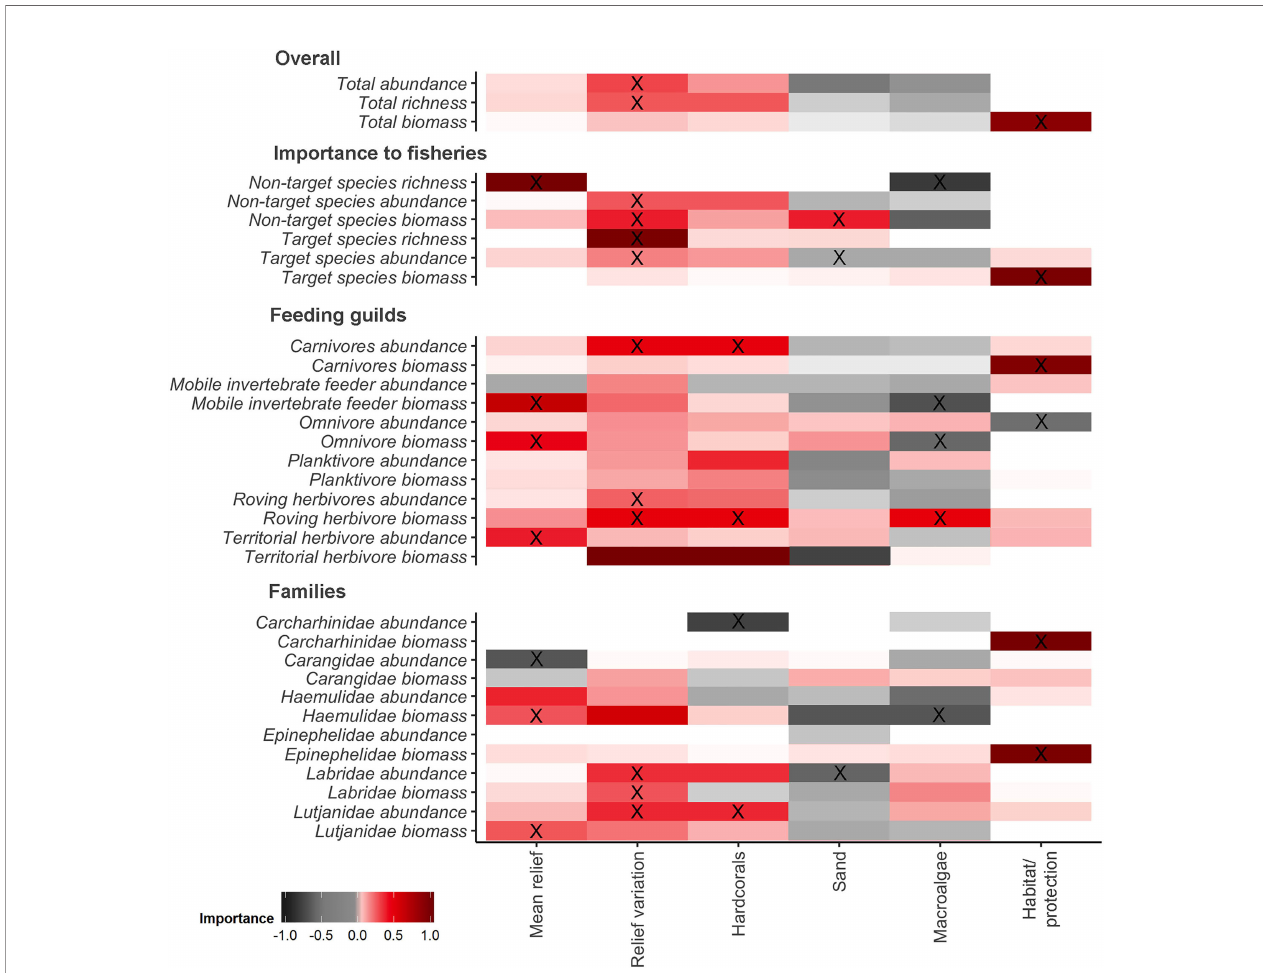
FIGURE 2 | Variable importance scores from full-subset generalized additive mixed models ’ analysis. X= Predictor variables within the most parsimonious model for each response